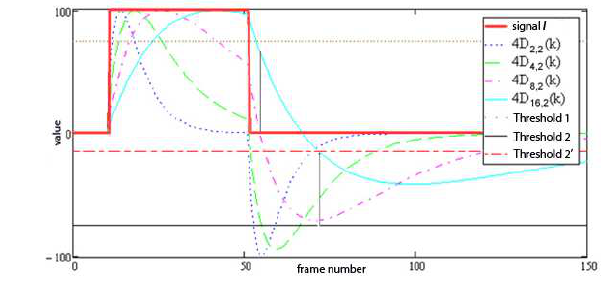
Figure 2: Pseudospectrum: accumulator derivatives D n,s ( k ) .